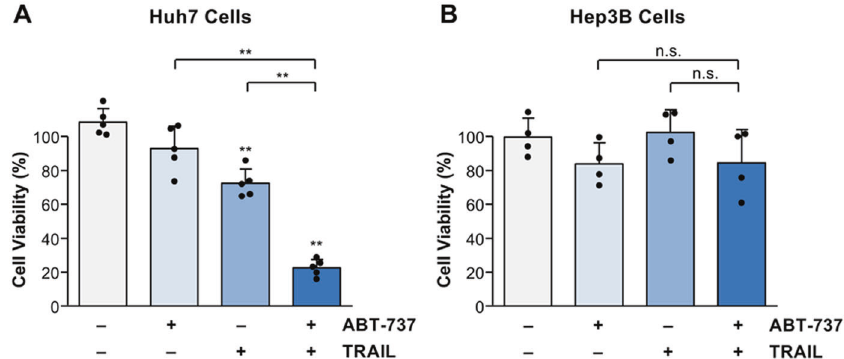
Fig. 5 ABT-737 sensitizes for TRAIL-induced cell death in Huh7 but not Hep3B cells. A Detection of cell viability in Huh7 cells treated with TRAIL (50 ng/ml) or ABT-737 (5 µM) alone or in combination for 8 h. TRAIL-mediated cell death was signi fi cantly increased by combination with ABT-737 in Huh-7 cells. B Neither TRAIL alone nor its combination with the BH3-mimetic reduced cell viability in Hep3B cells. Results of fi ve ( A ) or four ( B ) independent experiments are shown. Signi fi cances indicated above the bars refer to control. ** p < 0.01; n.s. non-signi fi cant. ef fi cacy end point [51, 52], it will be interesting to explore whether subgroups of patients with different expression of BH3-only proteins, such as NOXA, reveal a different treatment response to this drug combination. Further studies re-evaluating the expres- sion levels of BH3-only proteins in HCC patients treated with TRAIL-based therapies are therefore required.